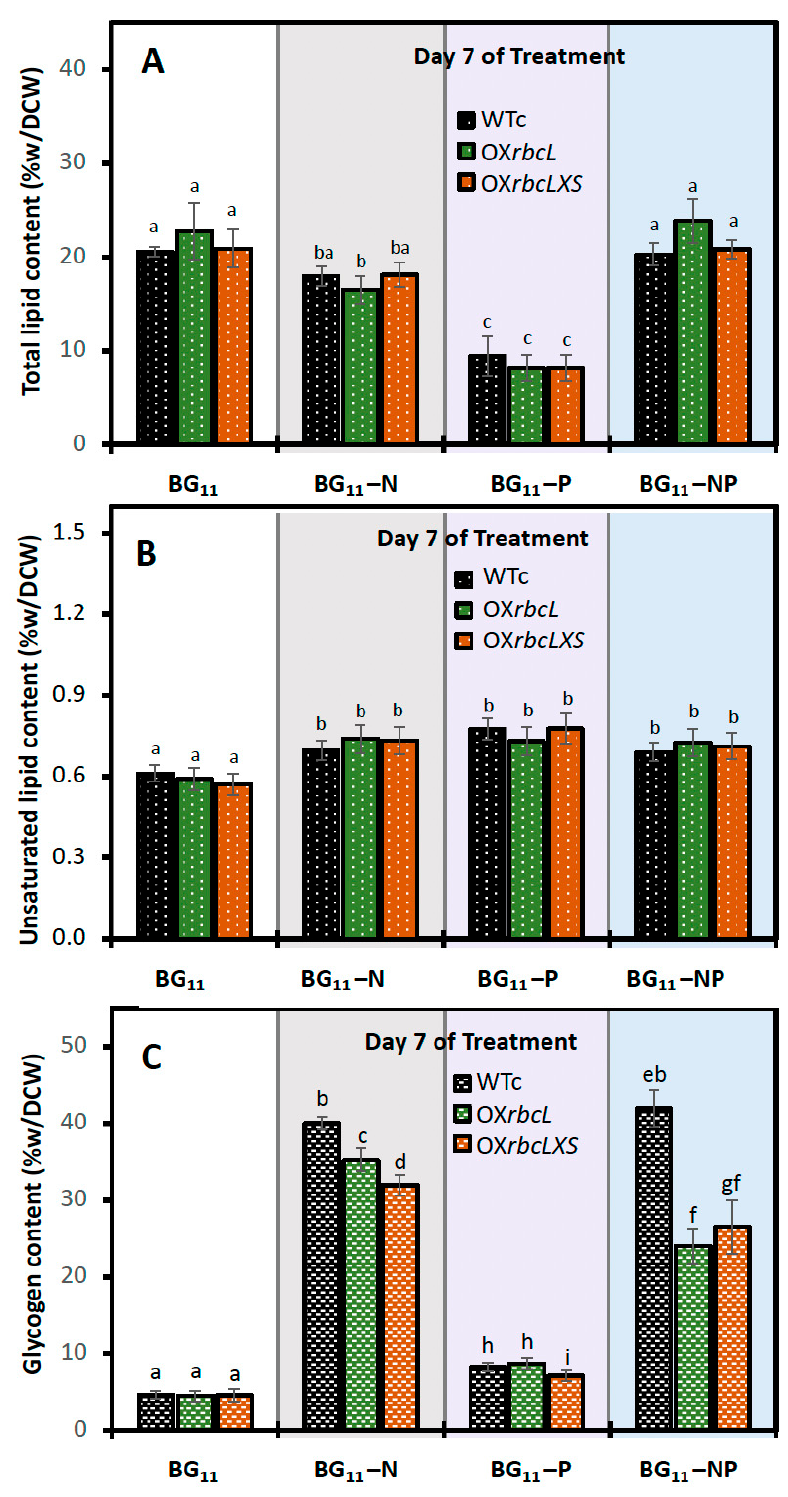
Figure 7. Contents of ( A ) total lipids, ( B ) unsaturated lipids, and ( C ) glycogen in Synechocystis WTc, OX rbcL , and OX rbcLXS strains after adapting in normal BG 11 medium, BG 11 -N, BG 11 -P, and BG 11 -NP for 7 days. The error bars represent standard deviations of means (means ± S.D., n = 3). Means with the same letter are not significantly different with the significance level at p < 0.05.